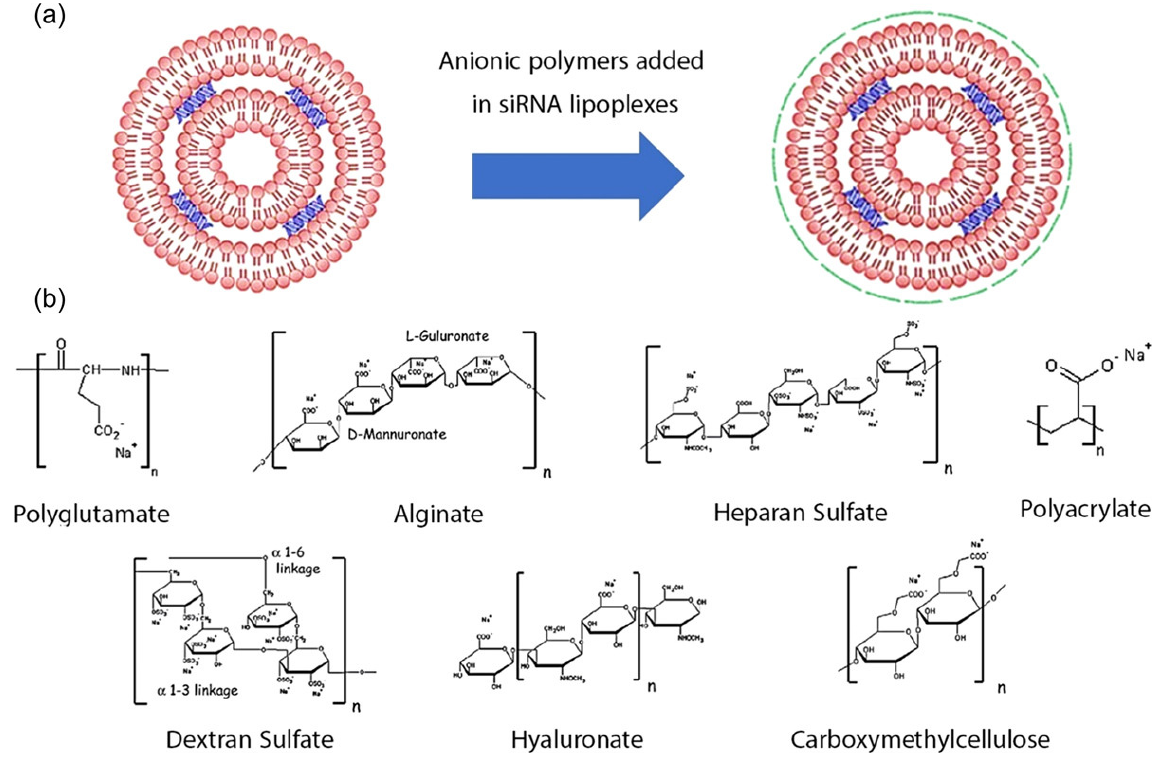
Figure 2. ( a ) Anionic polymers included in siRNA lipoplexes. ( b ) Different anionic polymers. Adapted with permission from Ref. [21]. Copyright © 2023-2022 John Wiley & Sons,